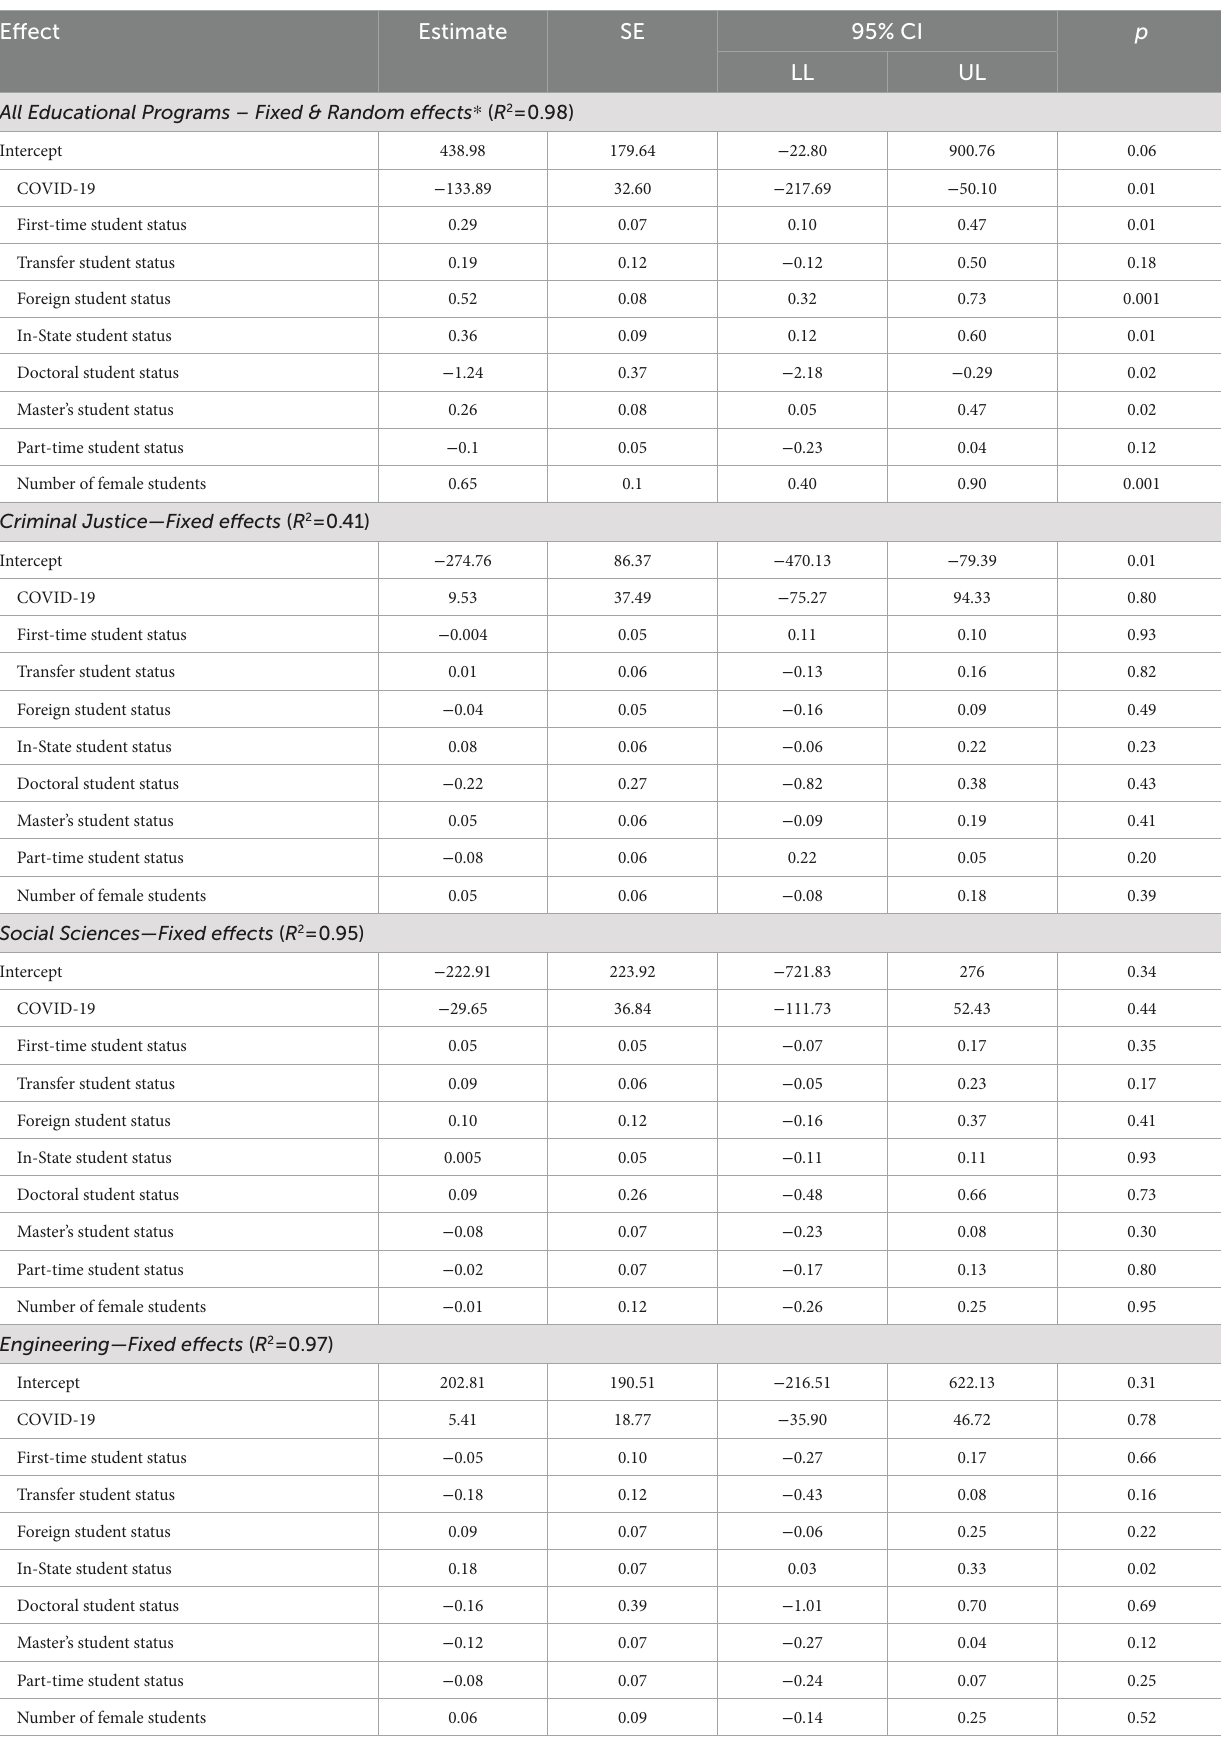
TABLE 6 Fixed and random effects model outputs for all educational programs and each individual type of educational program of interest. Effect